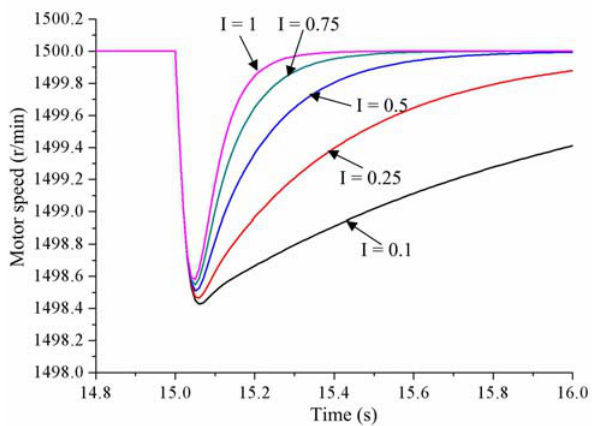
Figure 9. Simulated motor speed responses of the HESGS with different integral gains.